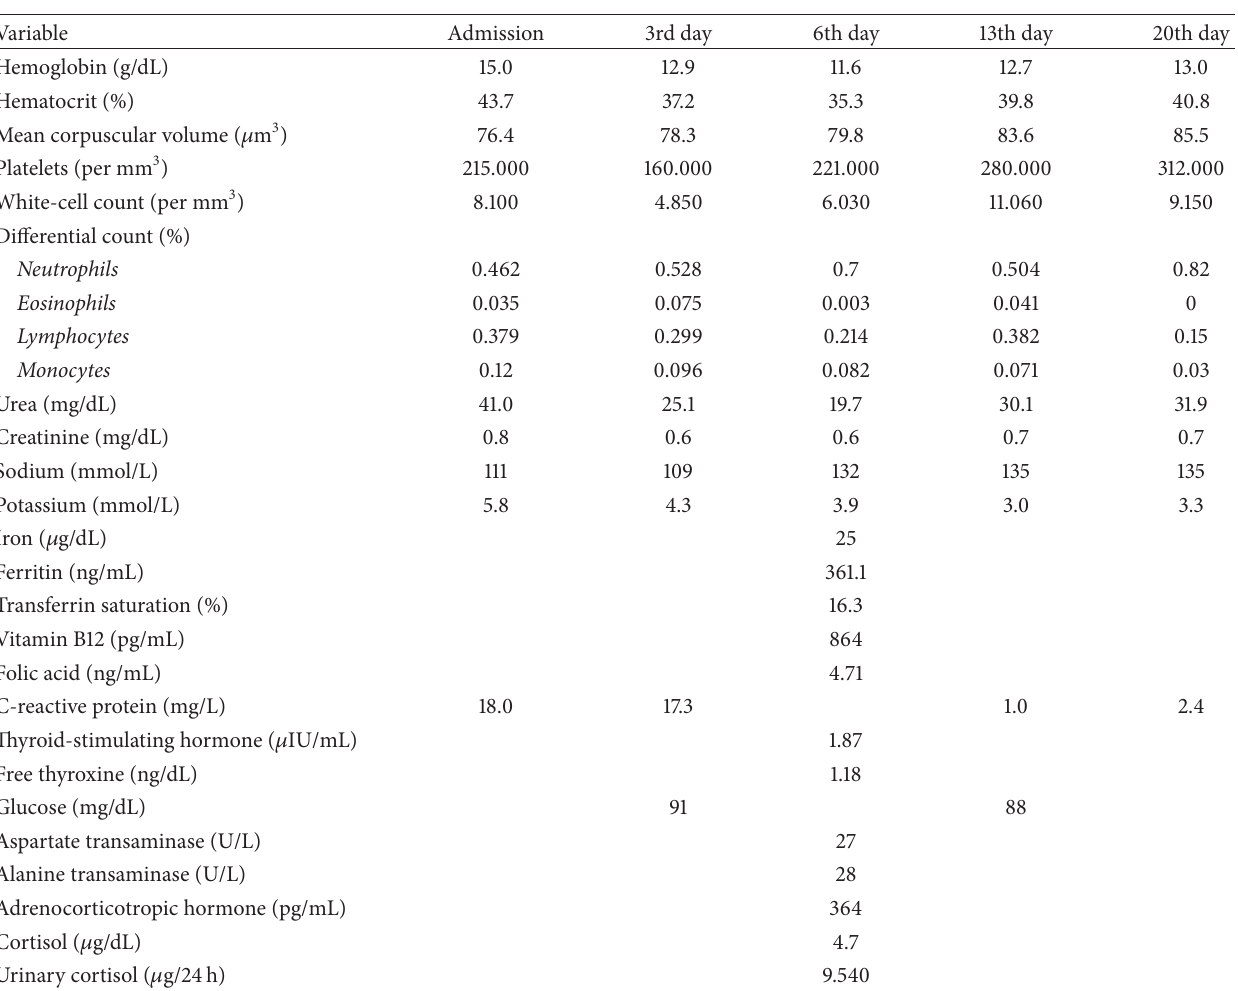
Table 1: Laboratorial